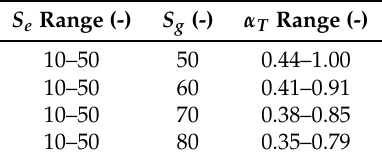
Table 3. Examples of possible geometric swirl number and α T combinations for a given effective swirl number range.